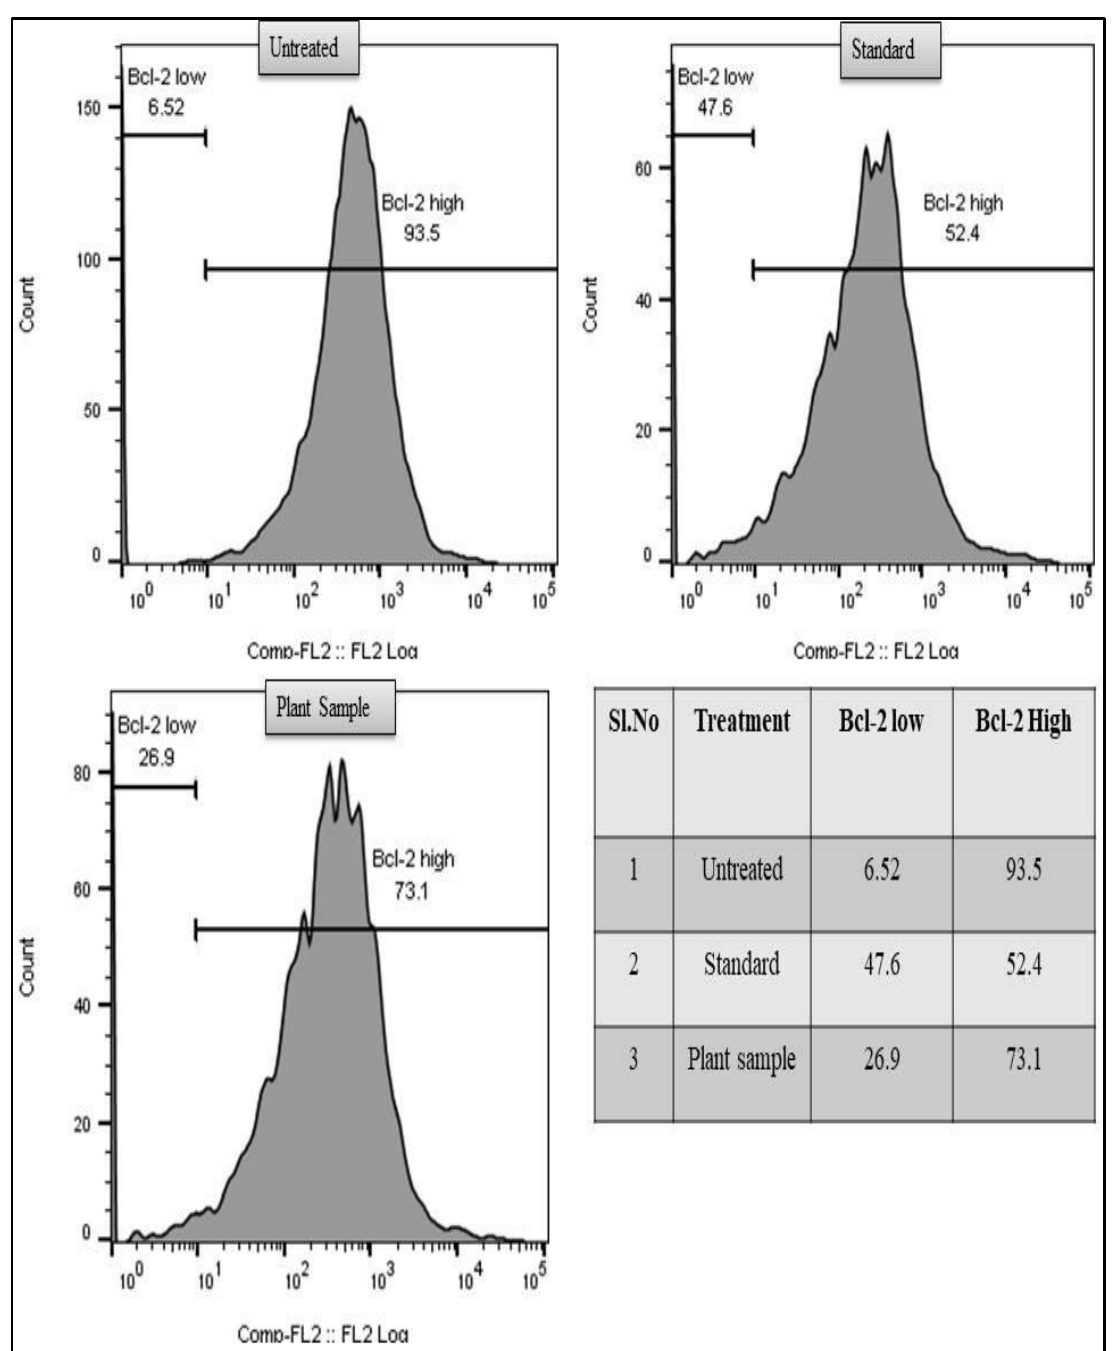
Figure 3. Flow cytometry-based study of inhibition of anti-apoptotic protein Bcl-2 through methanol extract of T. terrestris in the MCF-7 cell line.